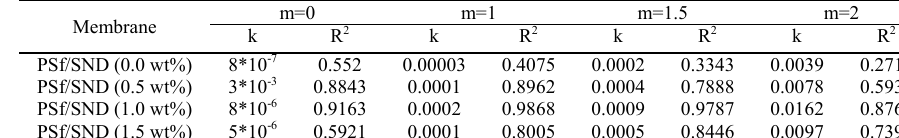
Table 4. Obtained k and correlation coefficient R 2 values for Hermia fouling models.